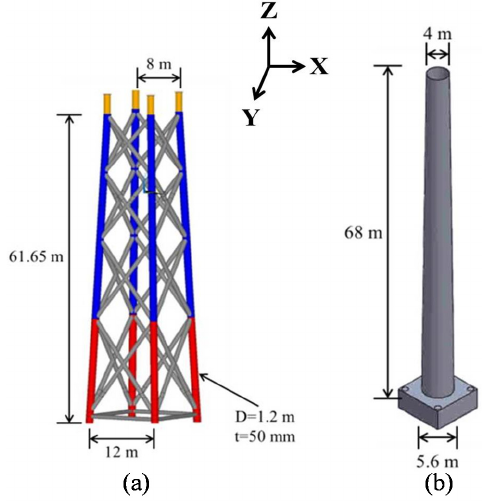
Figure 6. OC4 Jacket Substructure CAD Model ( a ); and Simplified Tower Model ( b ). Appl. Sci. 2016 , 6 , 307